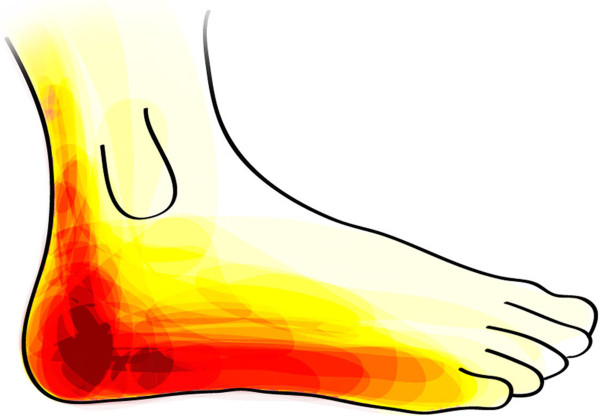
A combined illustration, i.e. a topographic map, of all the patients’ drawings of the subjective sensory loss. The more intense the red colour of certain areas was, the more patients have experienced symptoms from this area. In 5/41 (12%) cases, there was no drawing.